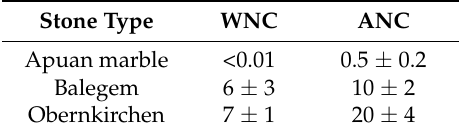
Table 3. Dry matter per unit area (mg/cm 2 ) absorbed by the stone specimens treated with WNC and with ANC (each value is the average from three treated